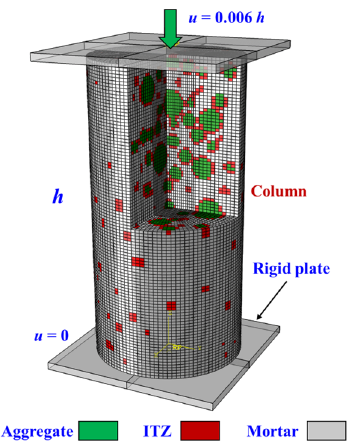
Figure 2. Mesoscale model of concrete cylinder.